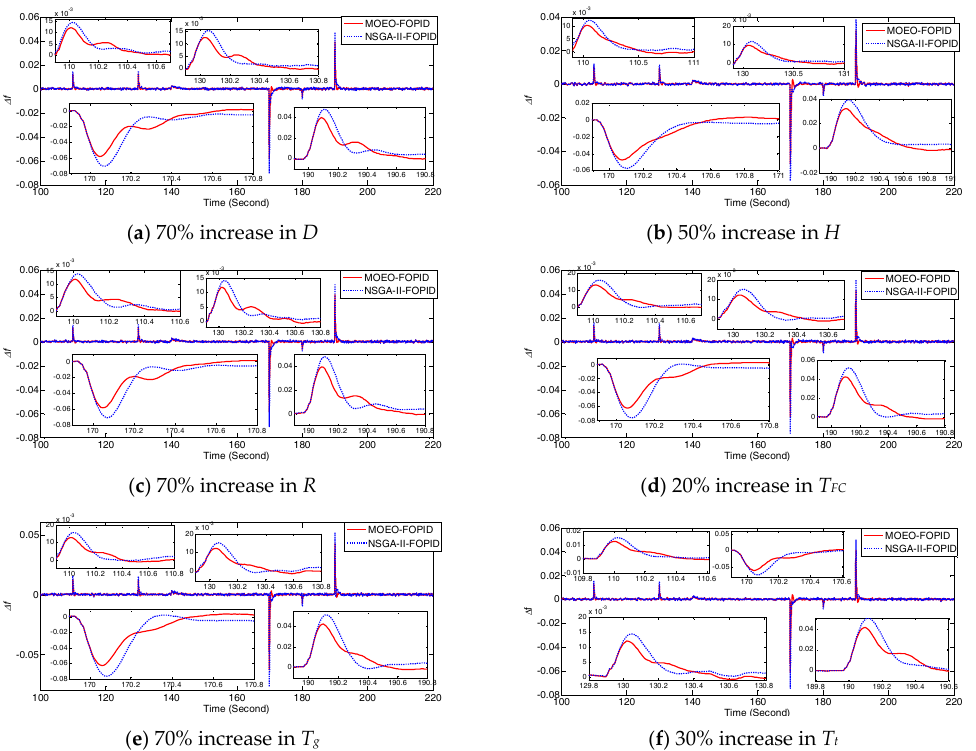
Figure 10. Comparison of the robustness against increased system parameters obtained by MOEO-FOPID and NSGA-II-FOPID.